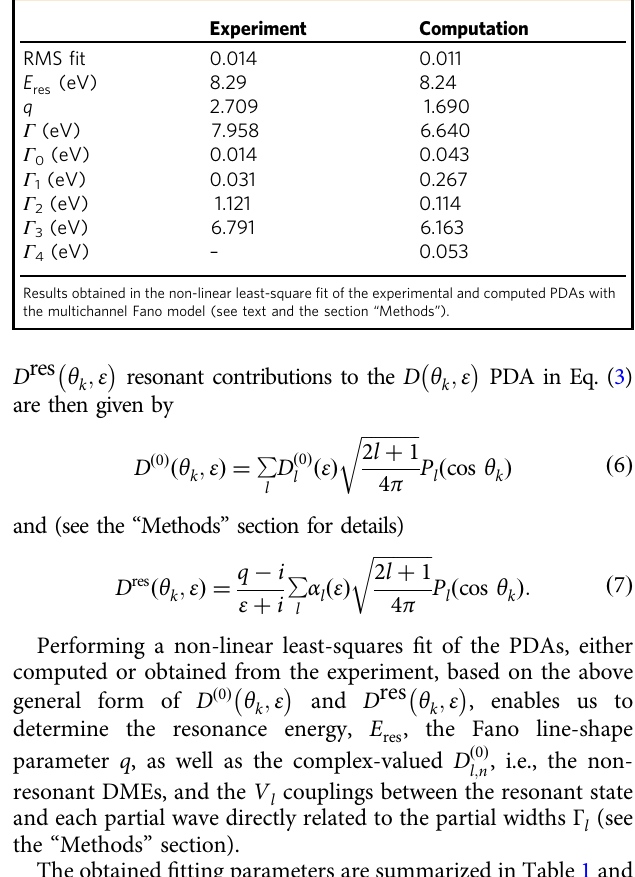
Table 1 Root-mean-square (RMS) deviation and fi tting parameters of the Fano fi